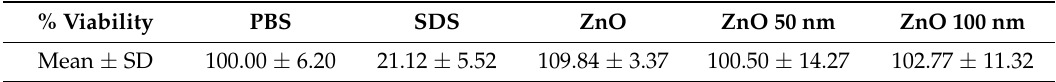
Table 2. Viability of the Episkin model determined by MTT after treatment for 24 h with 500 µ g/mL of different ZnO, 500 µ g/mL of sodium dodecyl sulphate (SDS) as a positive control and PBS as a negative control. Mean value ± SD of